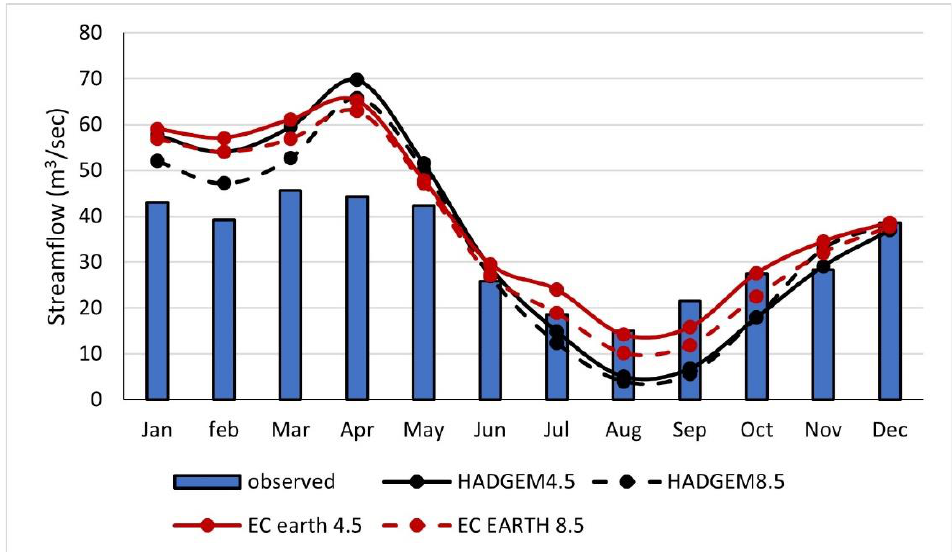
Figure 6. Average monthly streamflow for climate scenarios: RCP 4.5 and RCP 8.5 of GCM climate models: HadGEM2 and EC-Earth.